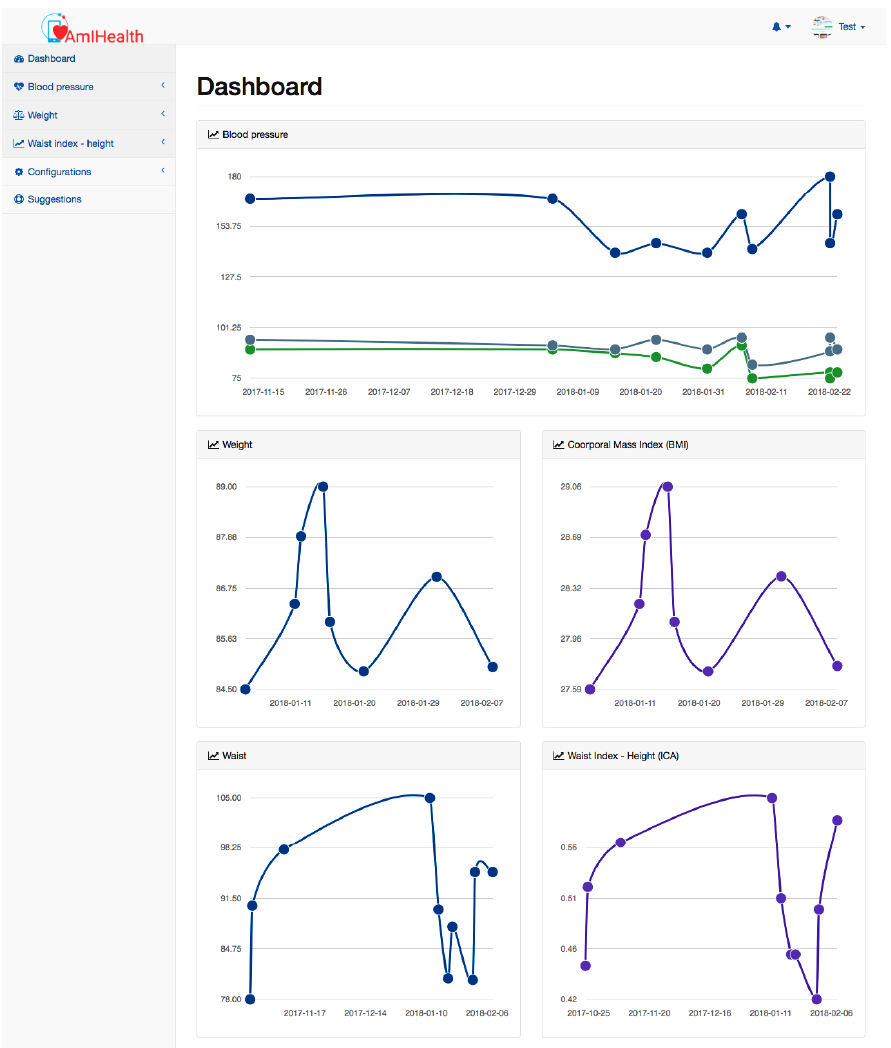
Figure 5. Dashboard. Figure 5.